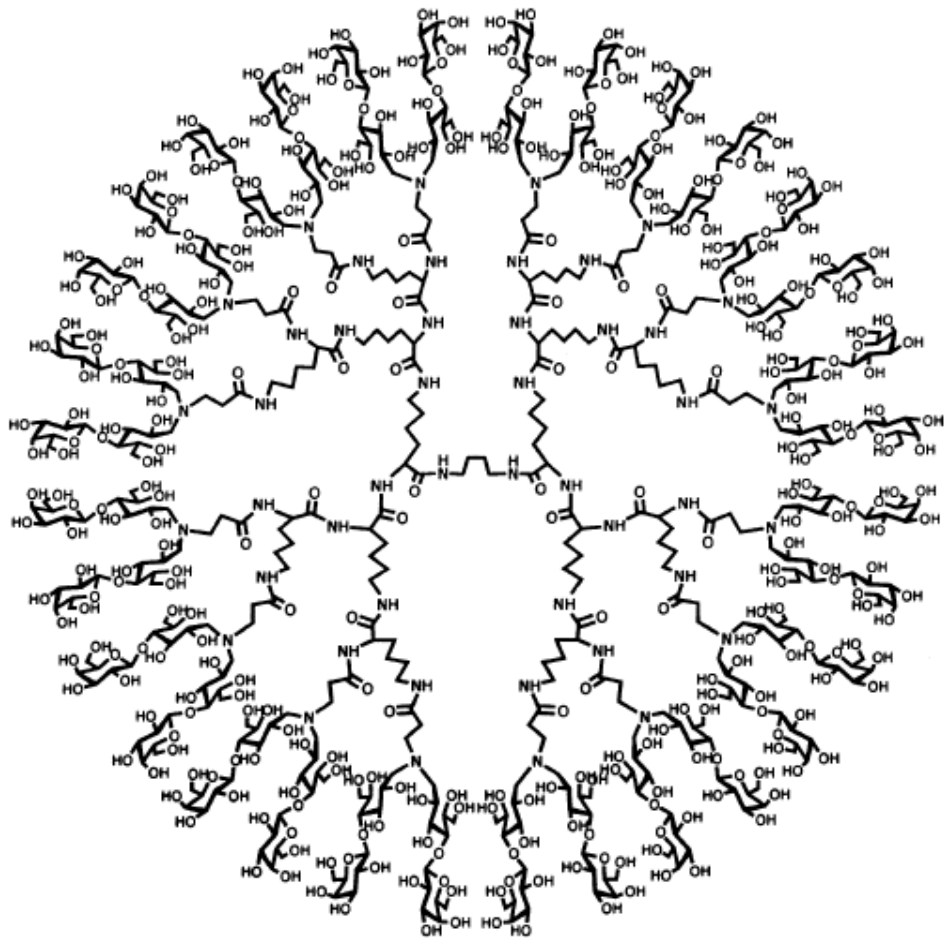
Figure 5. Oligosaccharide-decorated dendrimer, here maltose is attached via an alanine linker to a 3rd generation p( L -Lys) dendrimer; reproduced with permission from Baigude et al. [59].